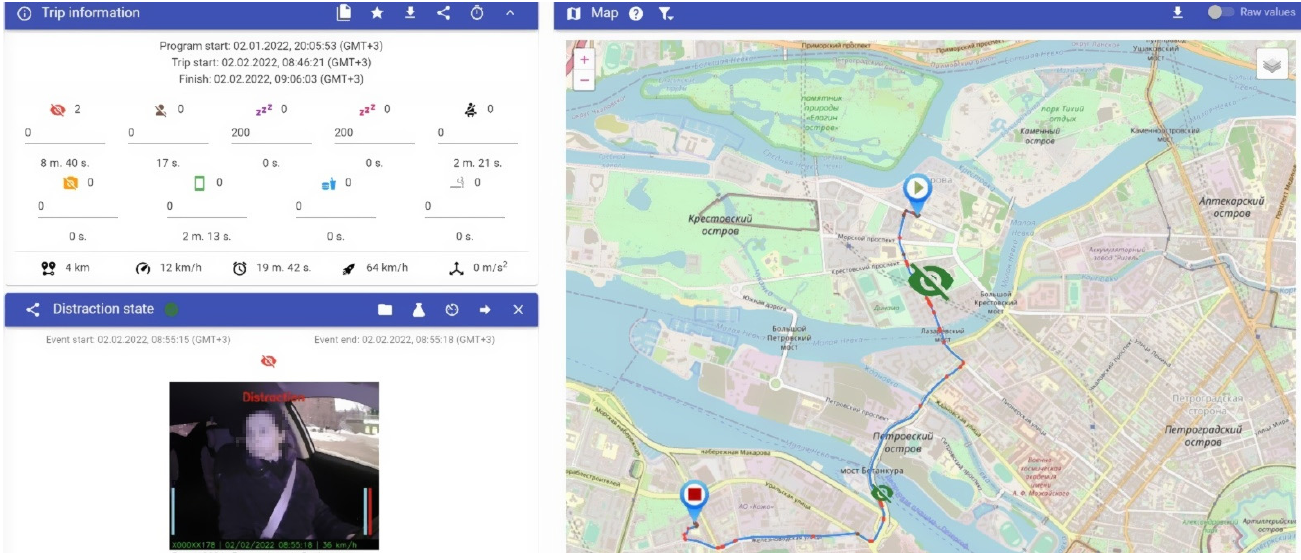
Figure 4. Screenshot example: vehicle route, threat lists, in-cabin, and outside